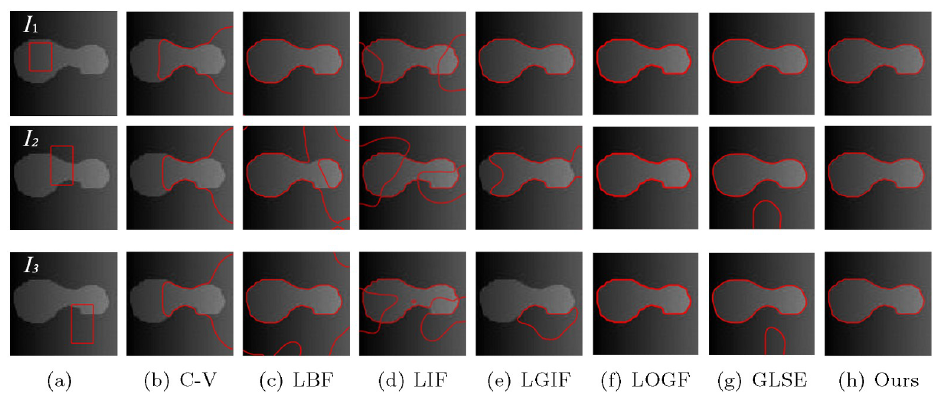
Fig 9. Comparisons for a synthetic image with varying initial contours.